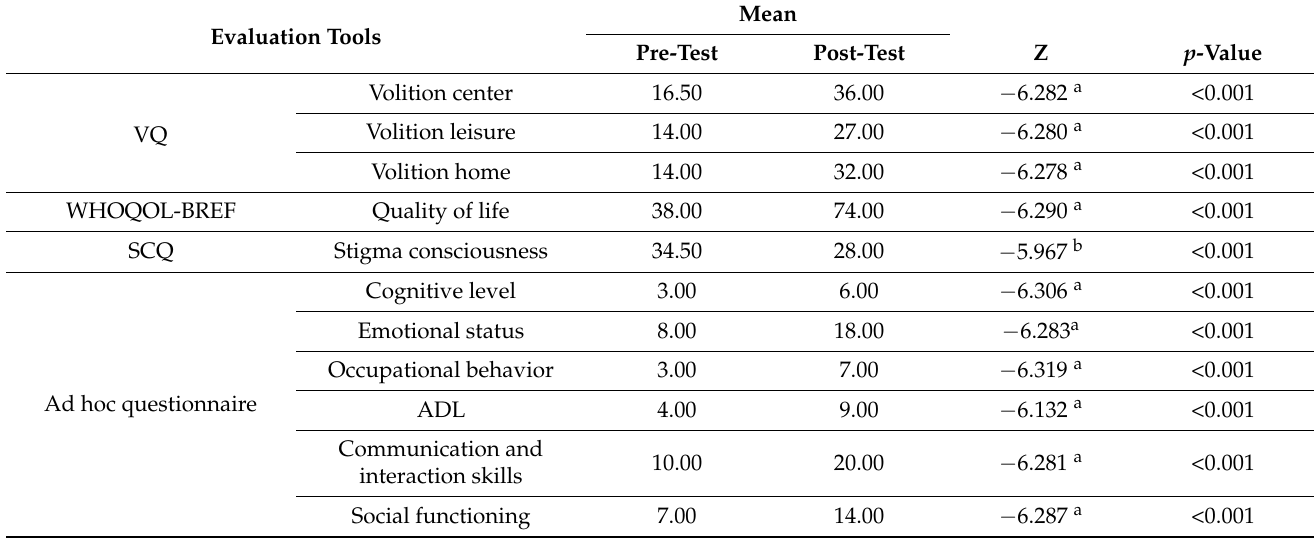
Table 1. Pre- and post-test comparisons in the group of people with disabilities.